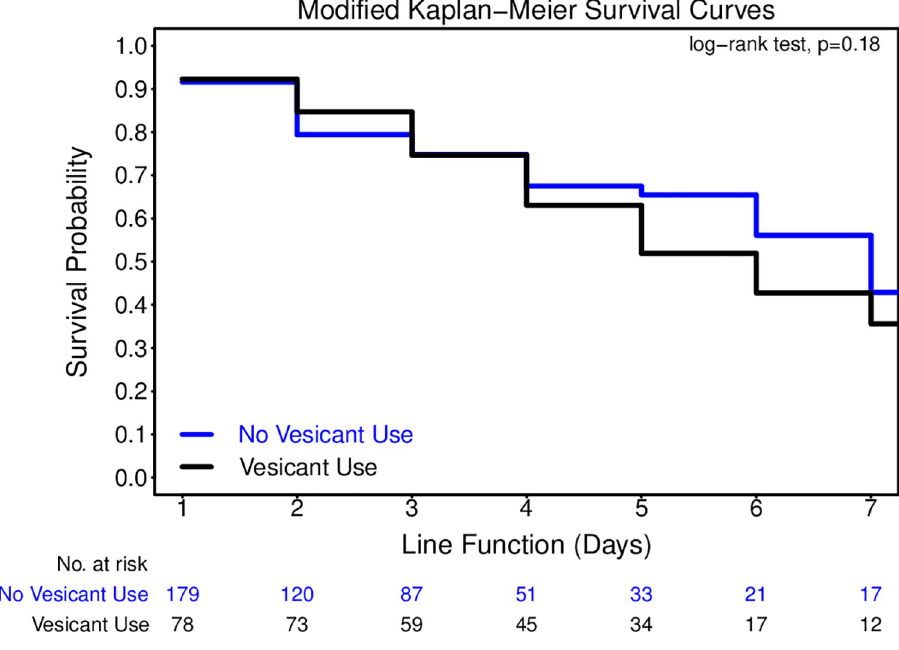
Fig 1. Modified Kaplan-Meier survival curve estimates by status of vesicant use for PIVC survival.